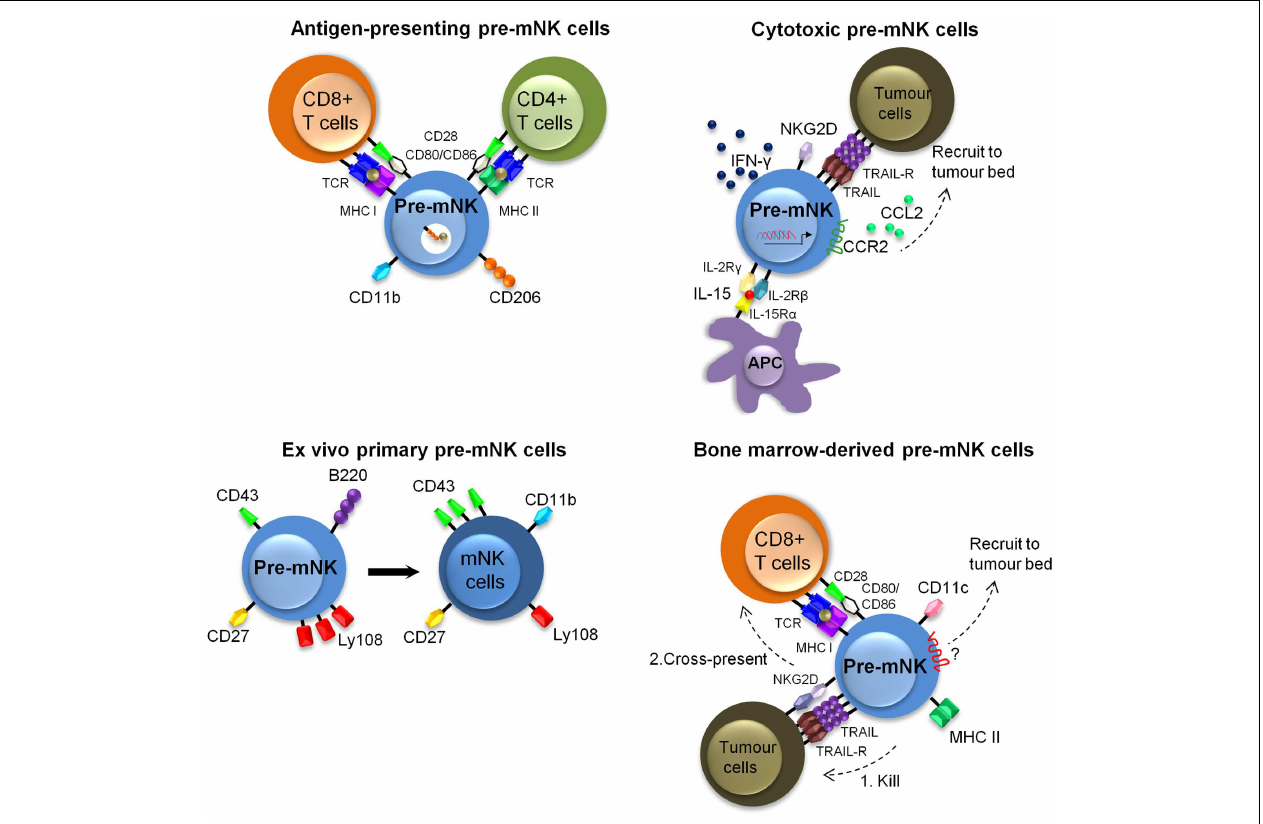
receptors on pre-mNK cells which facilitates the recruitment at tumor sites.The bottom left image portrays ex vivo isolated primary pre-mNK cells, which express high levels of Ly108 and low levels of CD43. Primary pre-mNK cells acquire an mNK cell phenotype upon in vivo transfer.The bottom right image illustrates that bone-marrow pre-mNK cells can be recruited to the tumor environment by an unidentified mechanism. Upon killing of a tumor cell, these bone-marrow pre-mNK cells are licensed to cross-present tumor antigens toT cells, initiating the adaptive immune